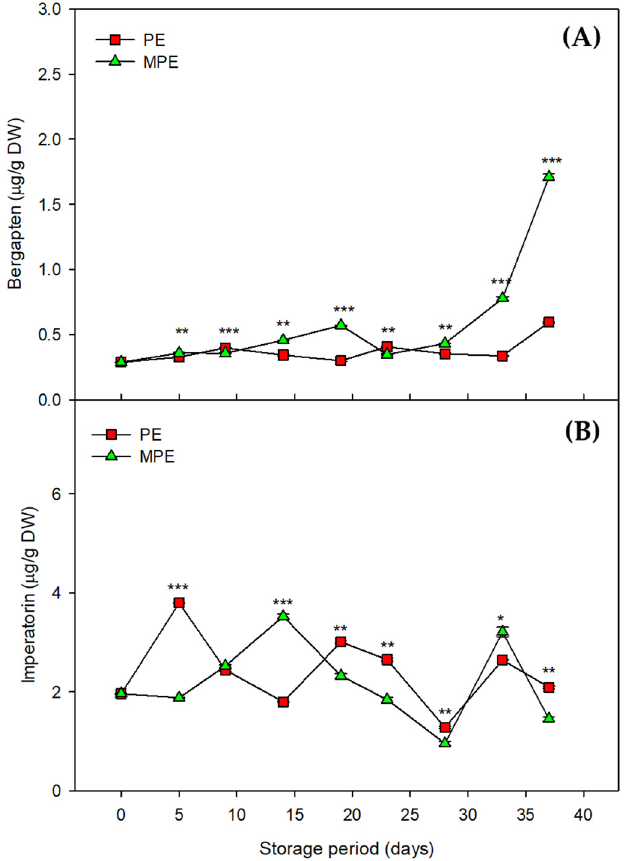
Figure 7. Changes in the coumarins of G. littoralis during storage at 4 °C. ( A ), bergapten and ( B ), imperatorin. MAP treatment was classified into micro-perforated PE (MPE, 32 pinholes) and PE on the basis of the presence or absence of pinholes, respectively. Values are shown as mean ± standard deviation. Statistical significance was shown by a t -test between PE and MPE at each time point during storage (*** p < 0.001, ** p < 0.01, and * p < 0.05).